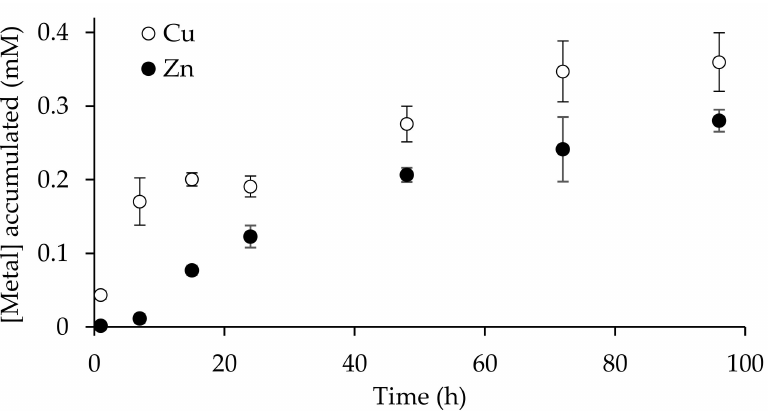
Figure 3. Metal accumulation at different times (individual studies). Feed phase: 100 mL of a 0.03 mM Zn or Cu in 0.01 M KNO 3 , pH 6.0; PIM: M2; receiving phase: 5 mL 0.01 M HNO 3 ( n =